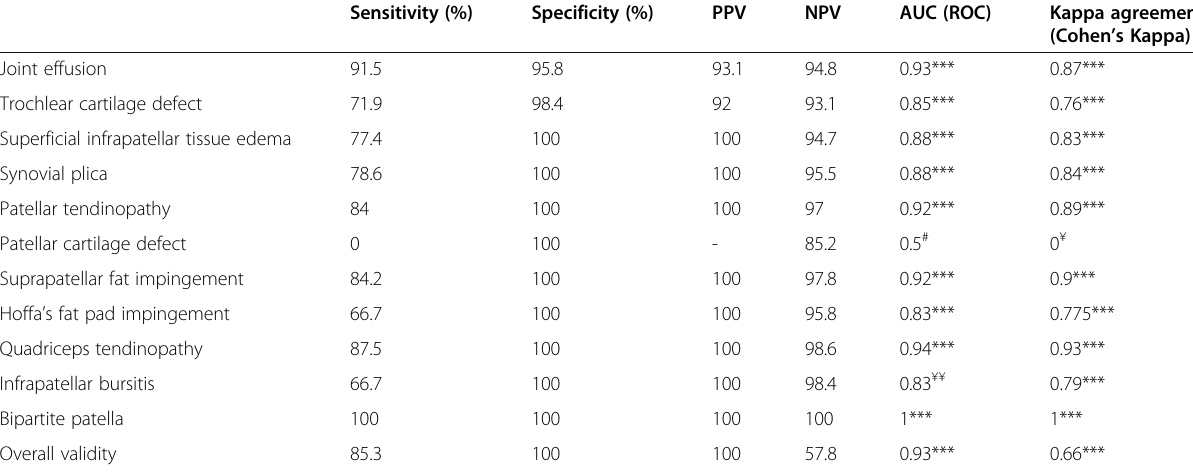
Table 4 Diagnostic accuracy of ultrasonography findings using MRI as the gold reference